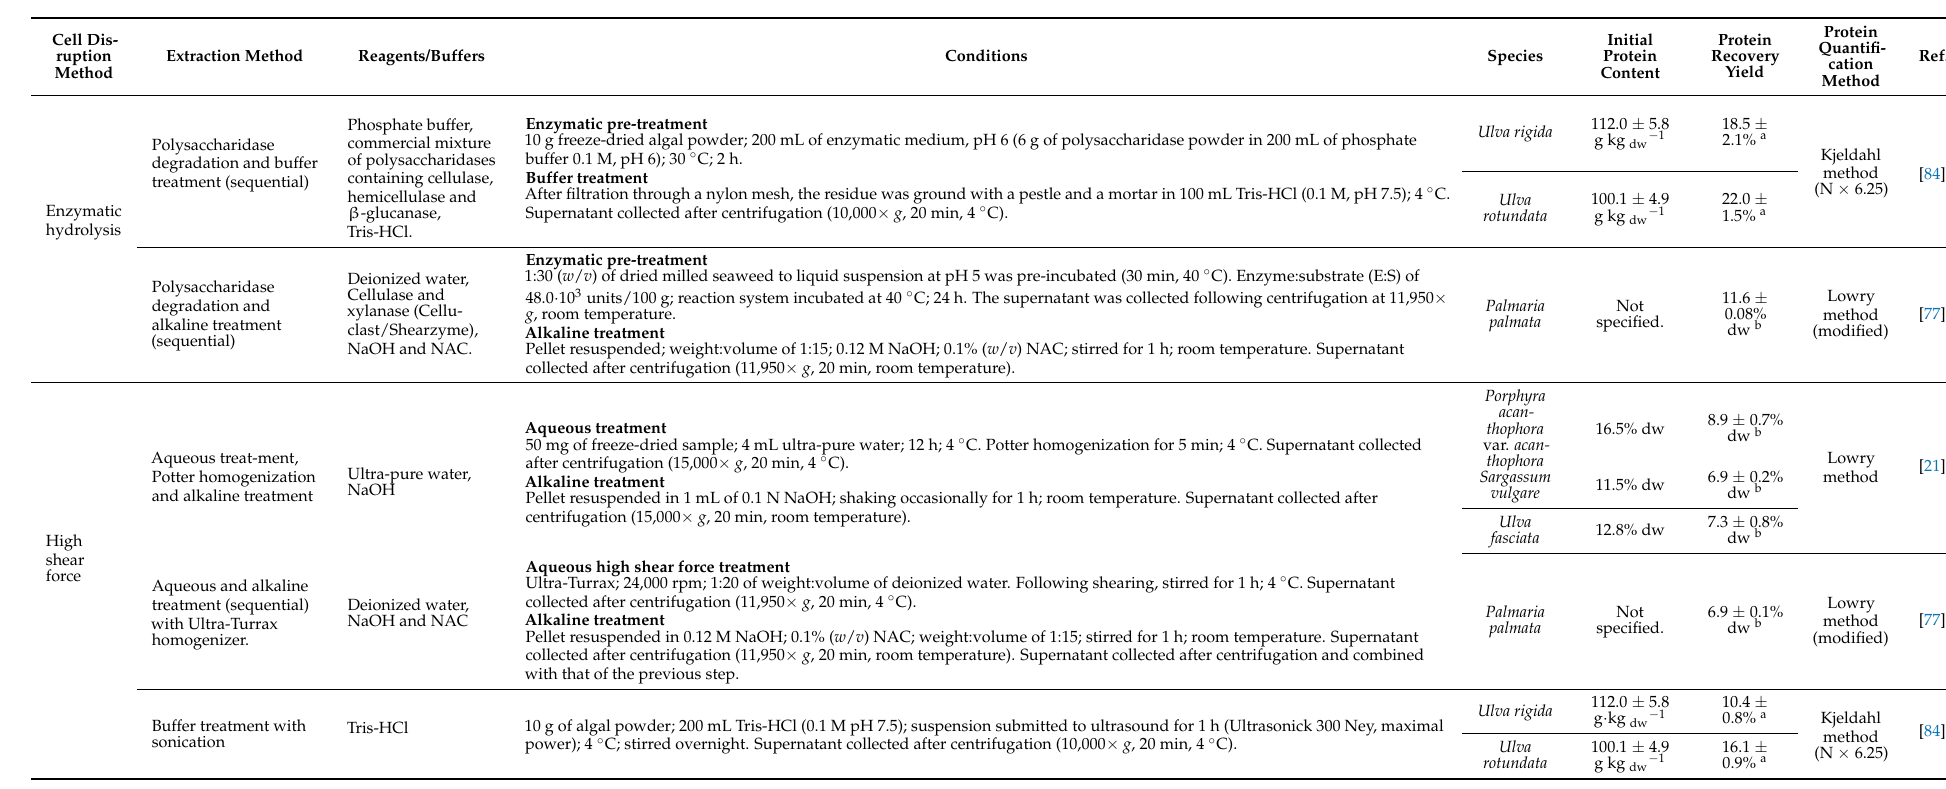
Table 3. The conventional, enzyme-assisted and ultrasound-assisted cell disruption and protein extraction methods applied to different